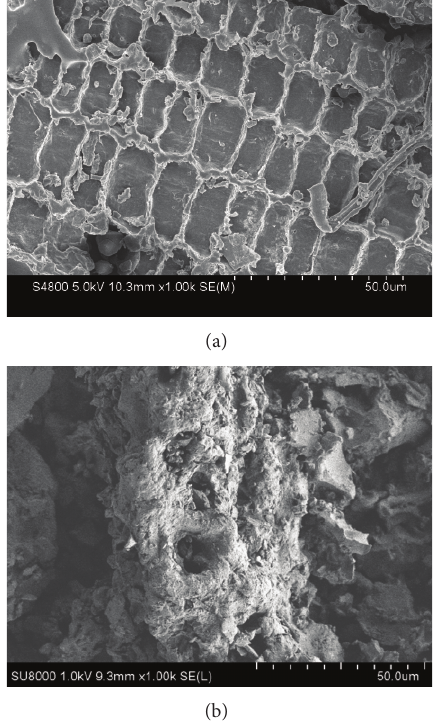
Figure 1: Scanning electron microscope (SEM) photographs of (a) Raw (RDBP) and (b) Aminated (ADBP) Desmostachya bipinnata .